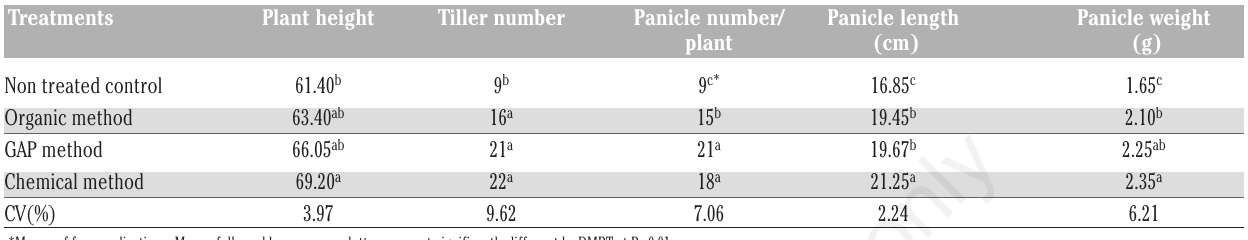
from Soytong & Quimio, 1989.9 Table 4. Growth parameters of rice var. Sen Pidoa in the field trial at 80 days. Treatments